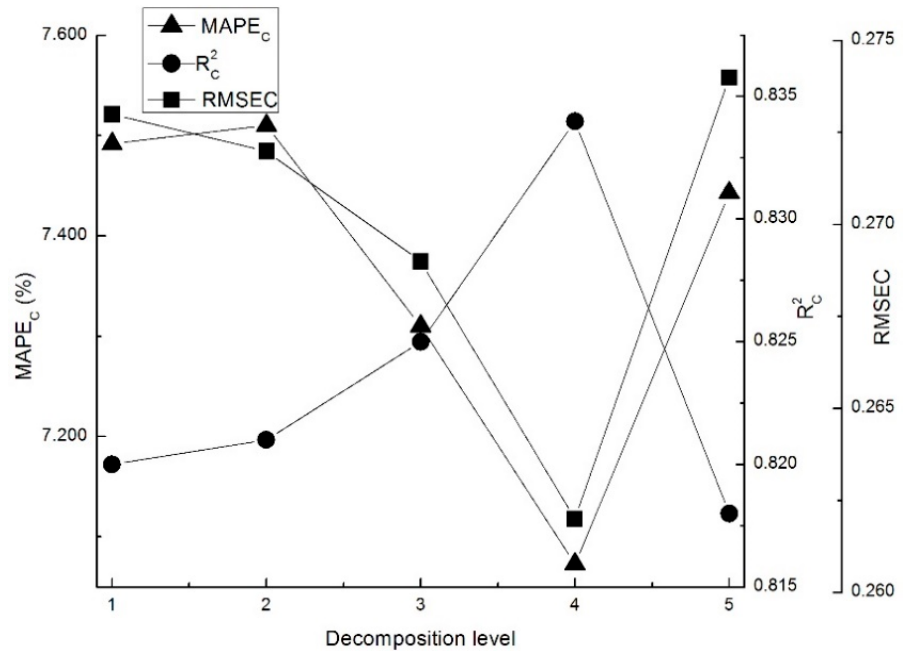
Figure 4. Results of PLS model for various decomposition levels of db2 wavelet.